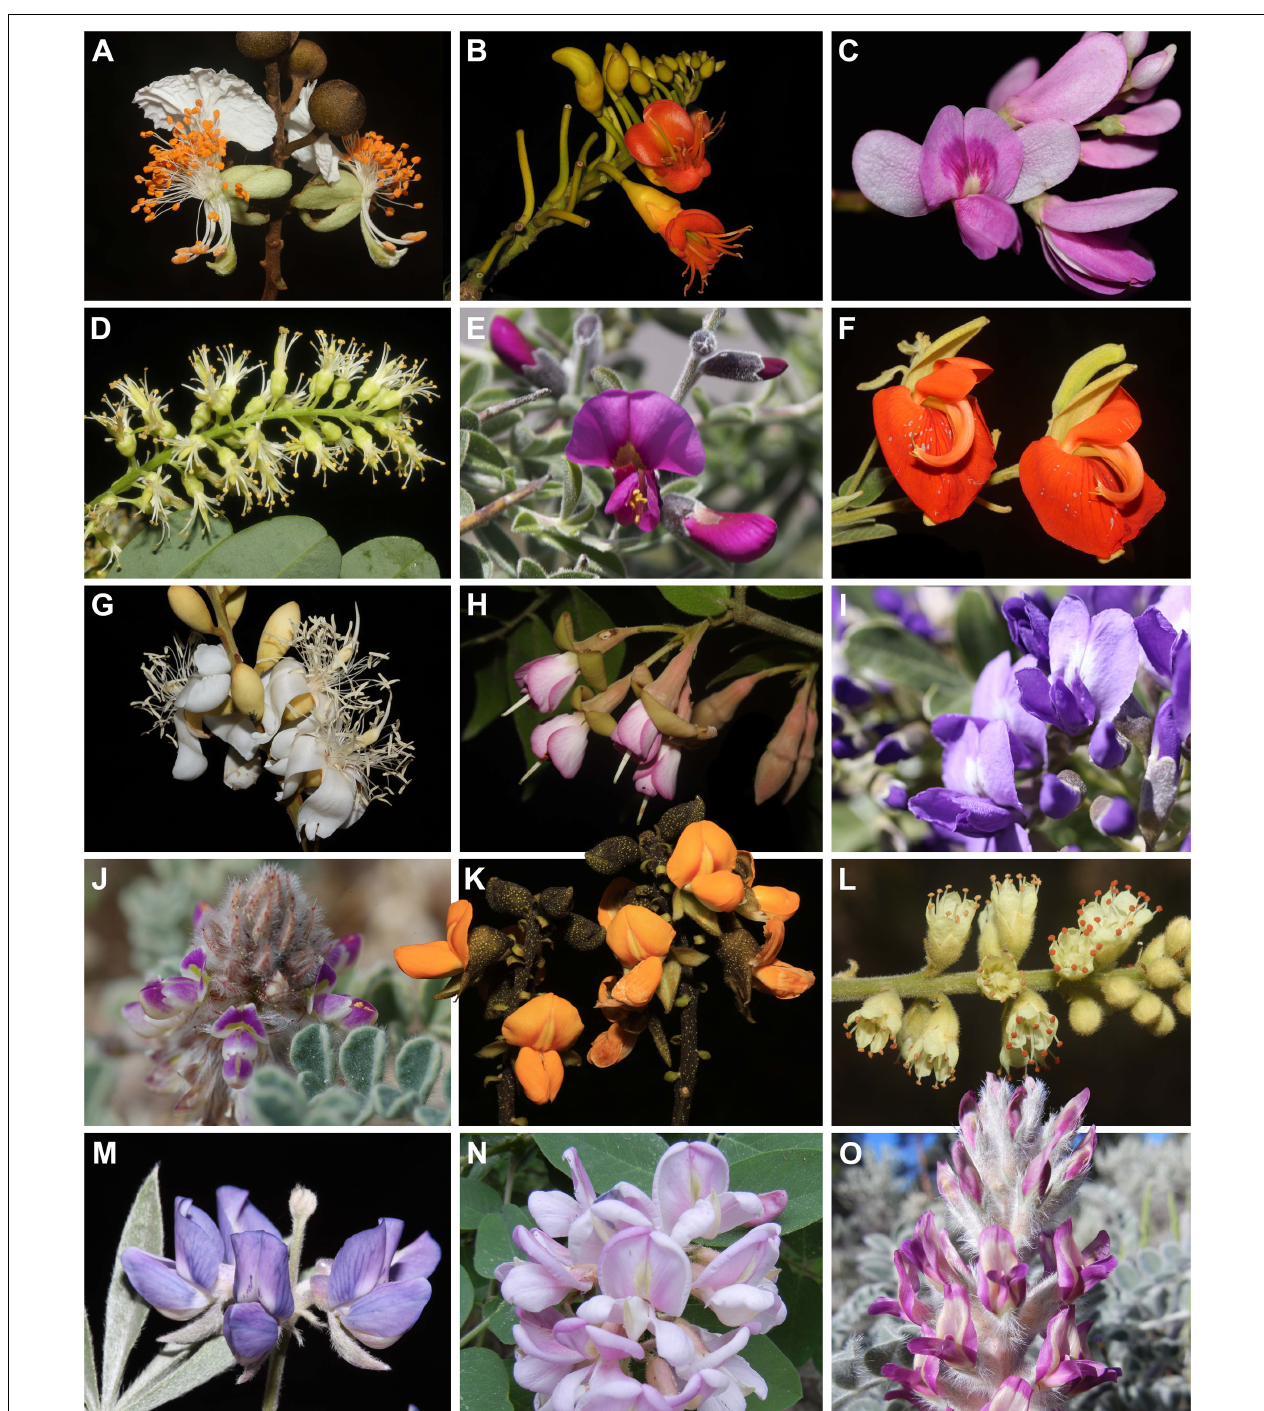
FIGURE 1 | Broad variation in floral architecture across the papilionoid legumes (Papilionoideae). The selected taxa represent genera from the early-branching lineages (A–M) outside the NPAAA (non-protein amino acid accumulating) clade. (A) Swartzia acutifolia (Swartzieae); (B) Castanospermum australe [Angylocalyceae, ADA clade (Angylocalyceae, Dipterygeae, and Amburaneae)]; (C) Dipteryx magnifica (Dipterygeae, ADA clade); (D) Myrocarpus fastigiatus (Amburaneae, ADA clade); (E) Pickeringia montana (Cladrastis clade); (F) Harpalyce brasiliana (Brongniartieae, Genistoid s.l.); (G) Aldina latifolia (Andira clade); (H) Exostyles venusta (Exostyleae); (I) Dermatophyllum secundiflorum (unresolved); (J) Dalea mollis (Amorpheae); (K) Centrolobium microchaete (Dalbergieae); (L) Leptolobium dasycarpum (Leptolobieae, Genistoid s.l.); (M) Lupinus sericeus (Genisteae, Genistoid s.l.); (N) Robinia neomexicana (Robinieae, NPAAA); (O) Astragalus mollissimus (Astragalean, NPAAA); Photos by Domingos Cardoso (A–D,F–H,K–M) and Martin F. Wojciechowski (E,I,J,N,O) .